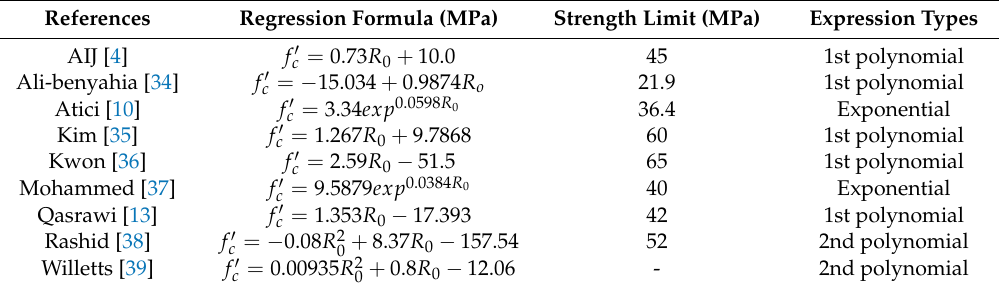
Table 4. Previous equations for the rebound hammer test.